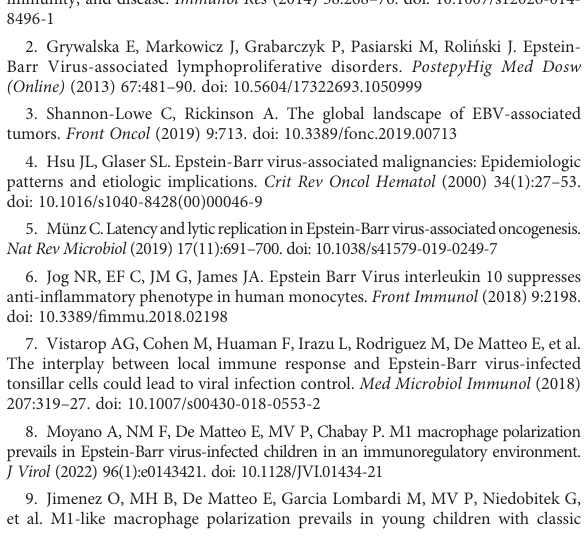
SUPPLEMENTARY TABLE 1 Infection status by EBV serological pro fi le. SUPPLEMENTARY TABLE 2 Lytic and latency pattern expression in infection status. On the upper row is shown the number of patients expressing lytic viral protein regardless of the latency